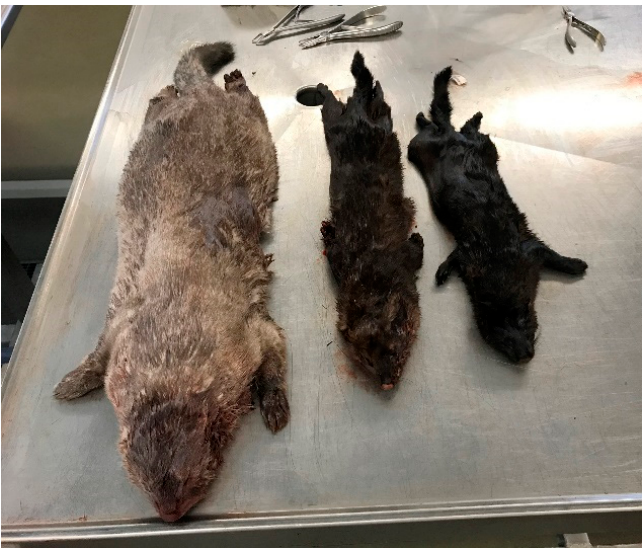
Figure 1. Male captive-born (left), male wild-born (middle), and female wild-born (right) mink.